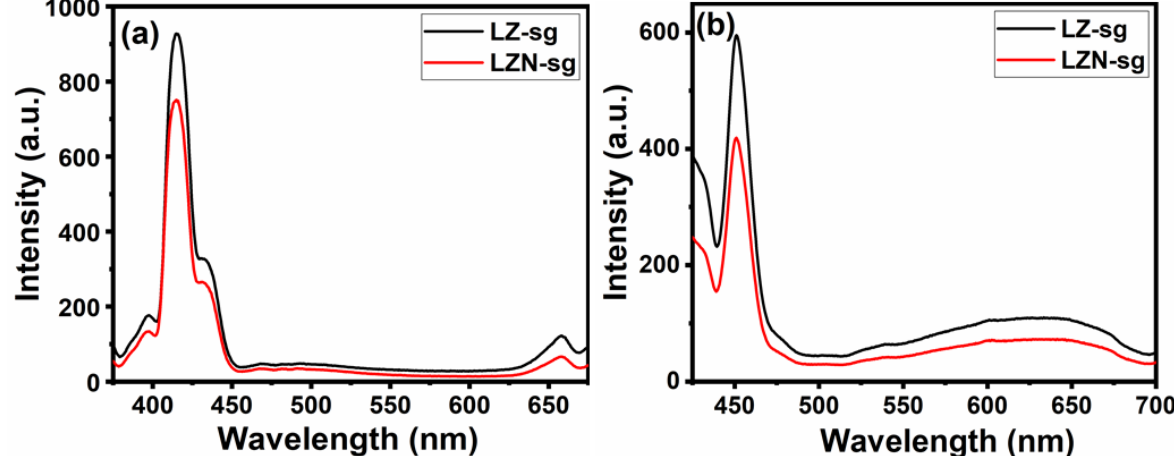
Figure 10. Photoluminescence emission spectra of LZ-sg and LZN-sg at two excitation wavelengths: ( a ) 350 nm, and ( b ) 400 nm, respectively. Table 4. Summary of photoluminescence emission spectra of La 2 Zr 2-x Ni x O 7